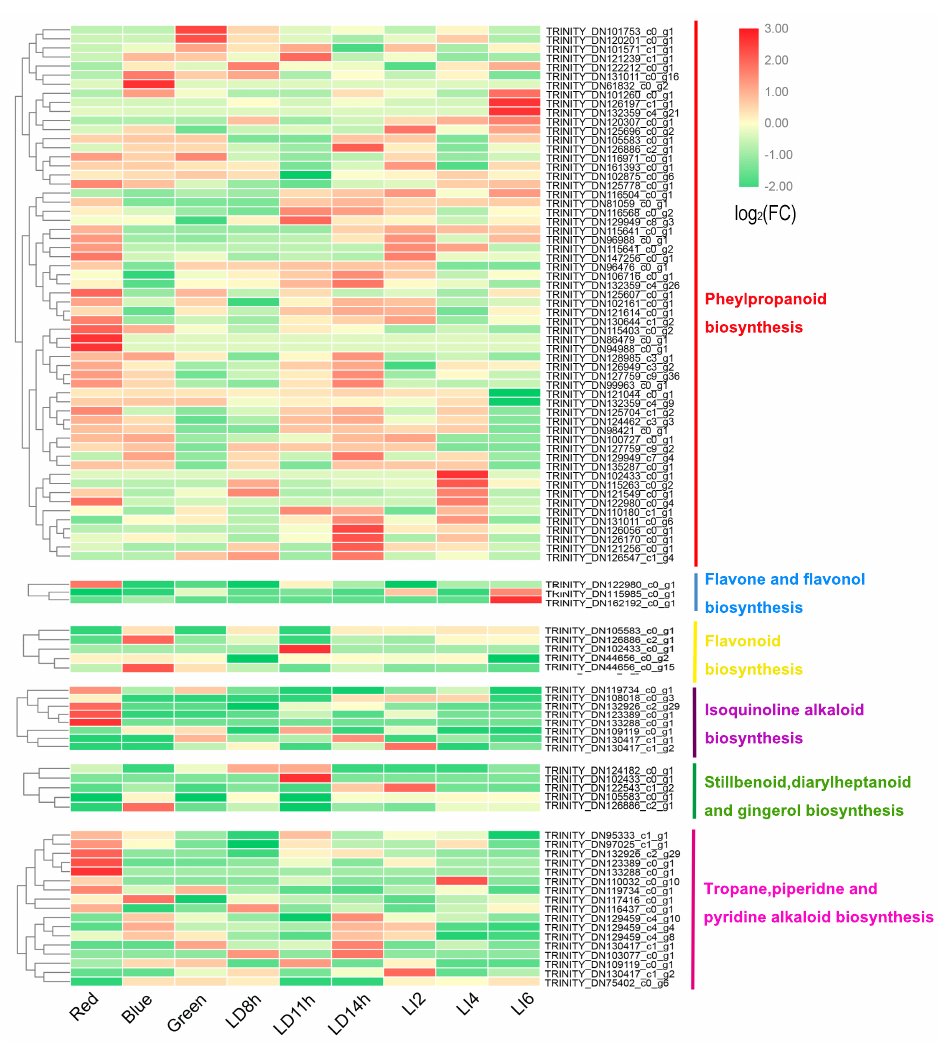
Figure 5. Expression profiles of the DEGs related to the secondary metabolism